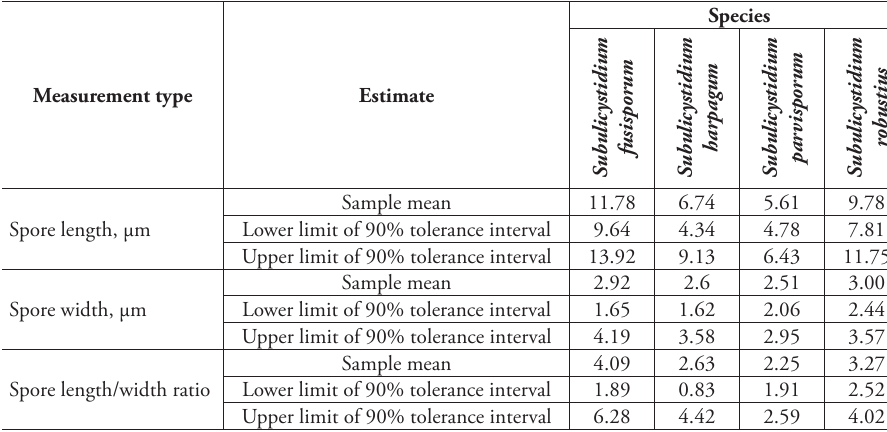
Table 2. 90% tolerance limits defined for the 90% probability level for the mean basidiospore length, width and length to width ratio for Subulicystidium species with at least 3 sequenced specimens. The fol- lowing specimens were used to estimate tolerance limits for species: Subulicystidium fusisporum : GB:KHL 9093, 10360 and 12761; S. harpagum : GB:KHL 10733, O:F:LR 15736, KAS:L 0244 and 1726a; S. parvisporum : KAS:GEL 5032, KAS:L 0140 and 1226 and LY 12750; S. robustius : GB:KHL 10039, 10272, 10780 and